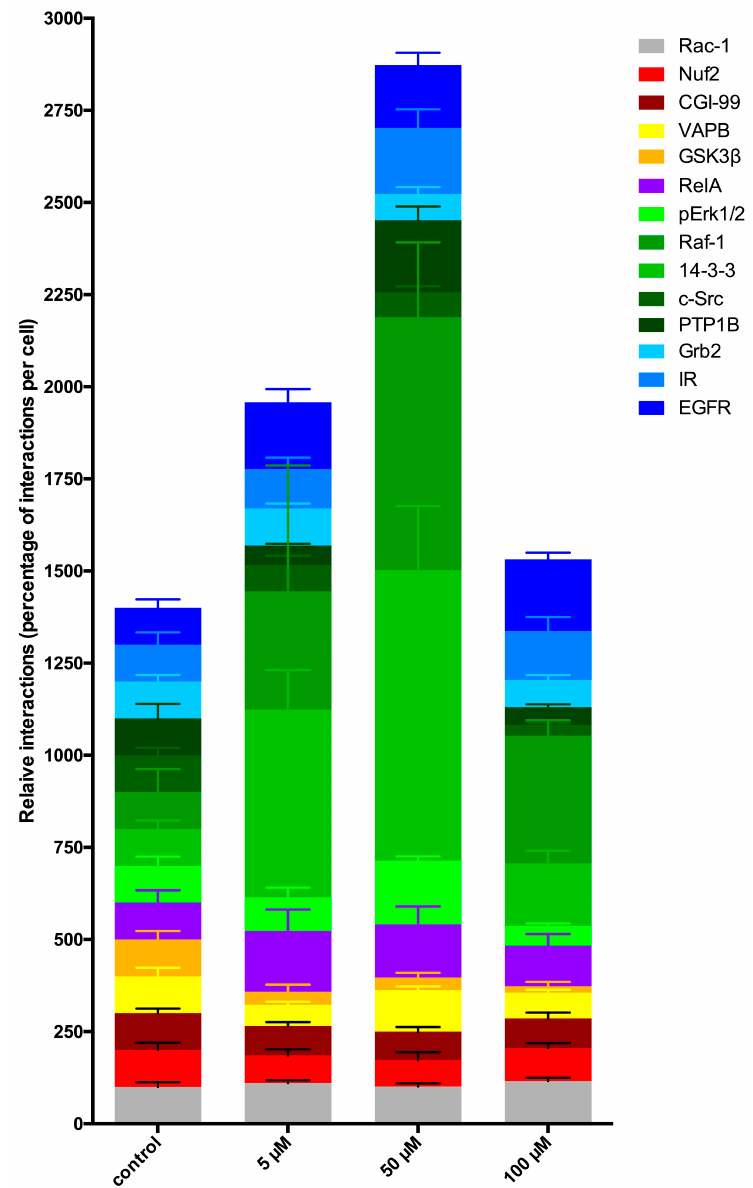
Figure 7. Cellular protein complex shift of PTPIP51 within 14 protein–protein interactions. Quantitative analysis of the Duolink proximity ligation assay of PTPIP51 with 13 different interaction partners in untreated and LDC-3 treated (5 µ M, 50 µ M and 100 µ M) HaCaT cells ( n = 4). The control values of 14 different PTPIP51 protein interactions were equalized to 100% (first stacked column) and the following columns show the standardized interaction values related to the controls (equaling 100%) for the applied LDC-3 concentrations. LDC-3 annuls the known regulatory phosphorylation mechanism of PTPIP51 with significant impact on the assembly of the PTPIP51 associated protein complexes. LDC-3 forces a protein–protein interaction shift of PTPIP51 and stabilizes the protein within MAPK complex on Raf-1 level through the scaffold protein 14-3-3. The remaining members of the PTPIP51 interactome are less affected by the administration of LDC-3. The color code for the single interactions is given at the upper right. The proteins belonging to the same signaling protein complex are coded by graded shades of the same color: blue corresponds to receptor tyrosine kinases and adapter molecules, green corresponds to the MAPK pathway molecules, red corresponds to mitosis associated proteins. For detailed information to the single interaction and their statistics see Figure 6 and supplementary Figures S3 and